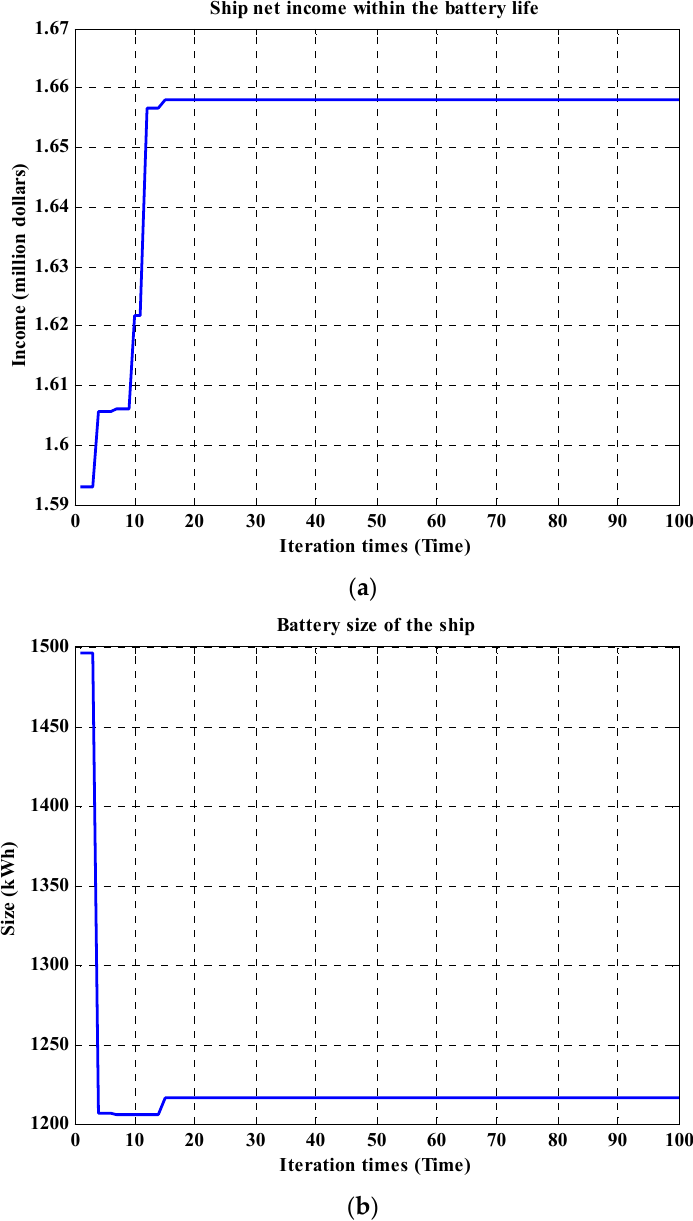
Figure 13. Simulation results of scenario 2 in case 2. ( a ) Variation of ship net income within the battery life over the optimization procedure ( b ) Battery capacity variation over the optimization procedure